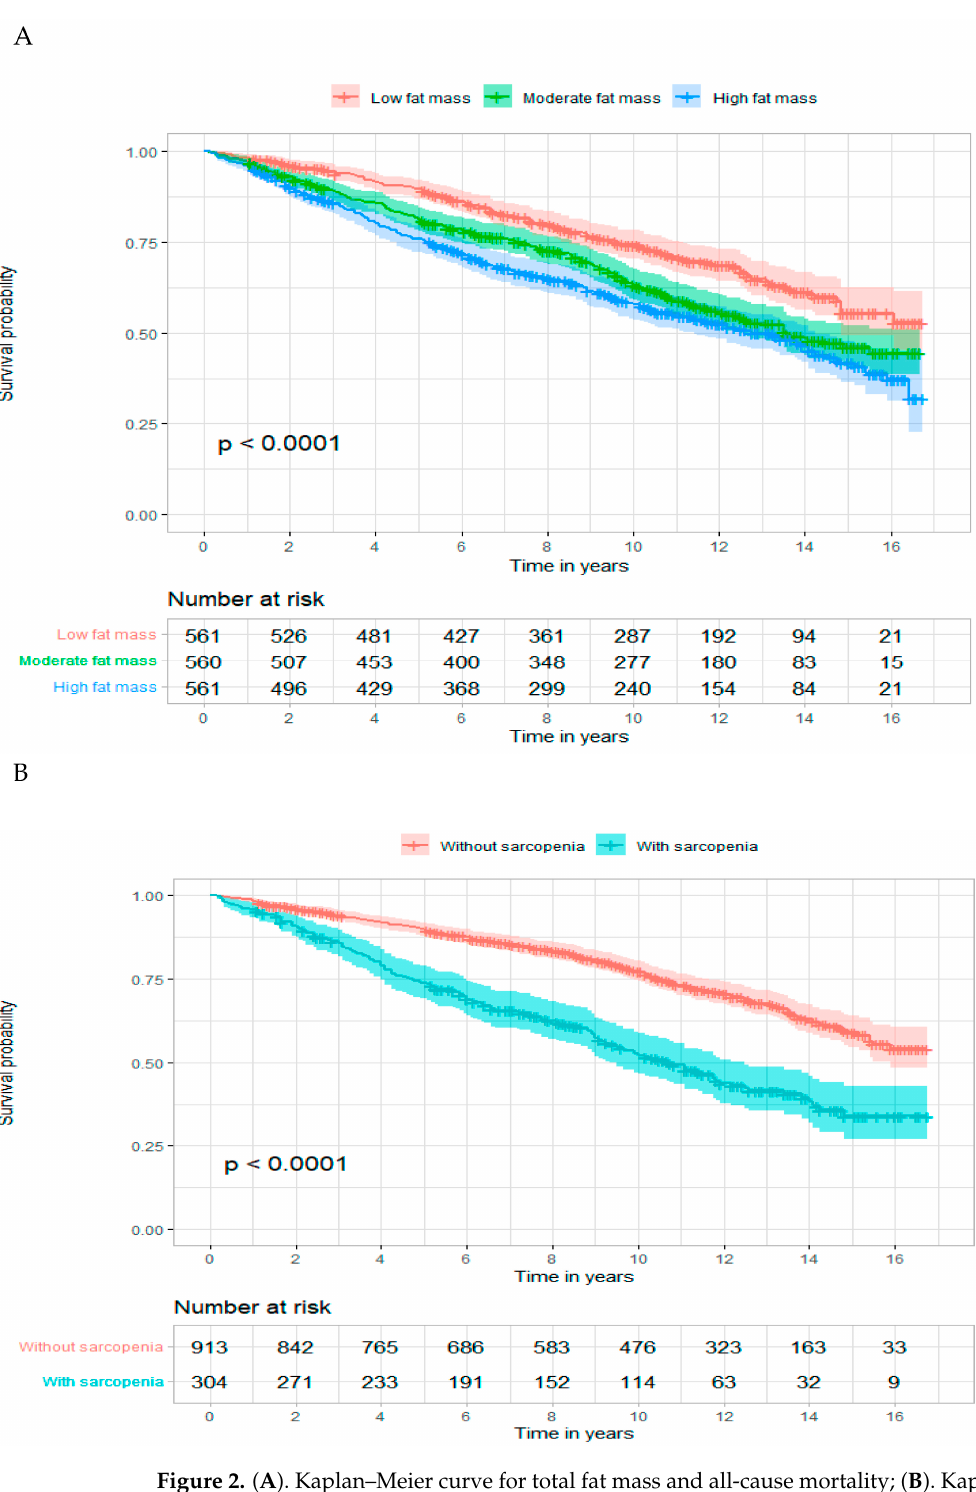
mental Table S2, a higher total fat mass (aHR = 1.33, [95% CI = 1.03–1.72], model 2) and